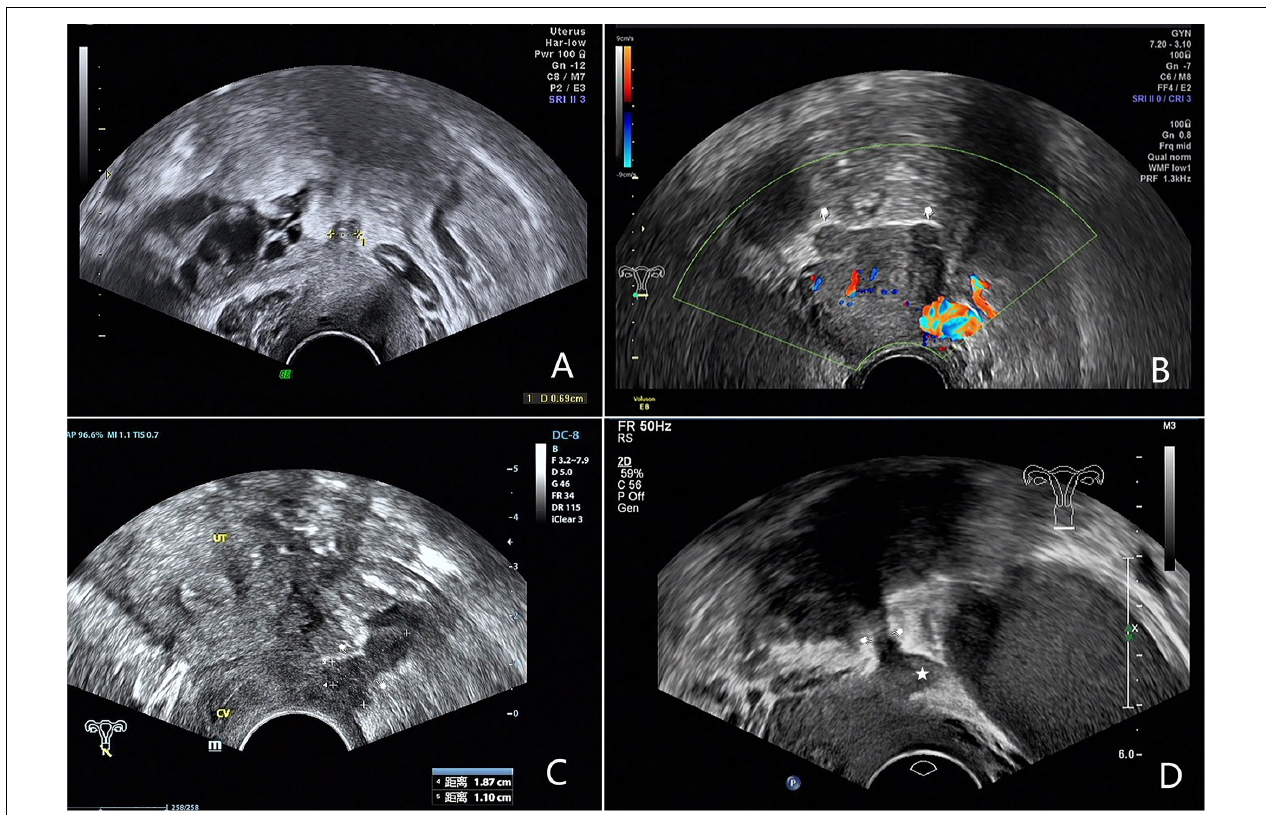
FIGURE 1 | Images showing four types of USL lesions according to ultrasound characteristics of USL endometriosis. (A) Type I: the root segament of USL is thickened and stiff. (B) Type II: the arrows show endometriosis nodules on both sides of the USL. (C) Type III: the arrows show hypoechogenic irregular striped endometriosis lesion. (D) Type IV: the arrows show irregular striped endometriosis lesion of the right USL, the Pentagram shows a nodule of the left USL.